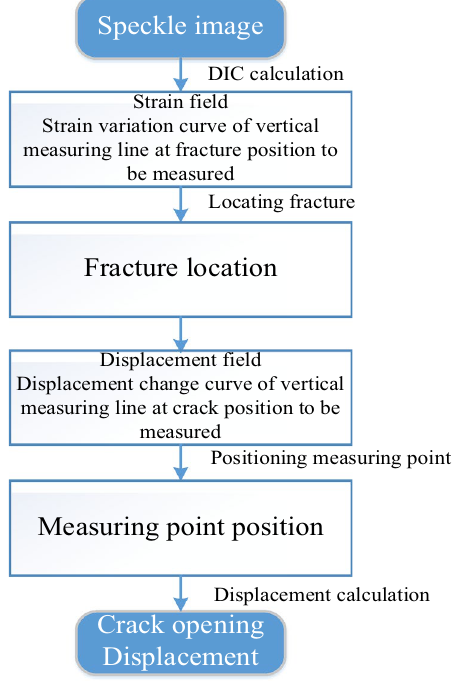
Figure 3. Implementation plan of improved method.